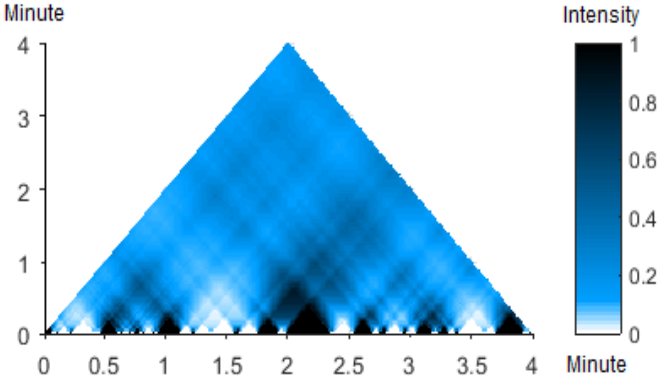
Figure 5. The interaction intensities between player 1 and player 6 during all time intervals for the attraction pattern.